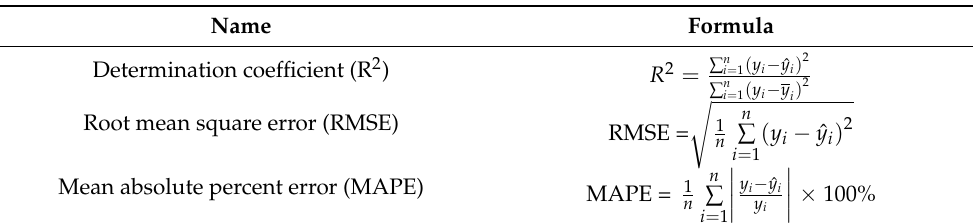
Table 2. Basic statistical indicators. Name